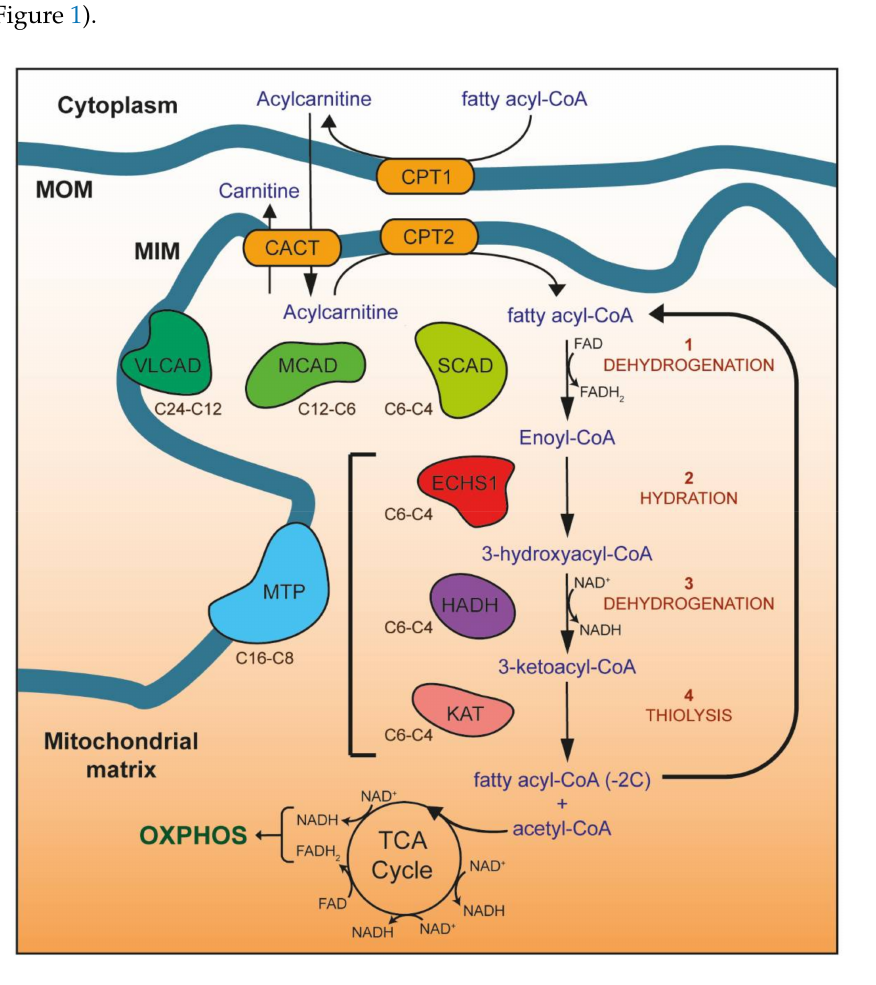
Figure 1. Mitochondrial fatty acid β -oxidation (FAO). Enzymes of the carnitine shuttle system (yellow) are responsible for transporting fatty acyl-CoA esters into the mitochondrial matrix as acylcarnitines. Carnitine is added to fatty acyl-CoAs by carnitine O -palmitoyltransferase 1 (CPT1), forming